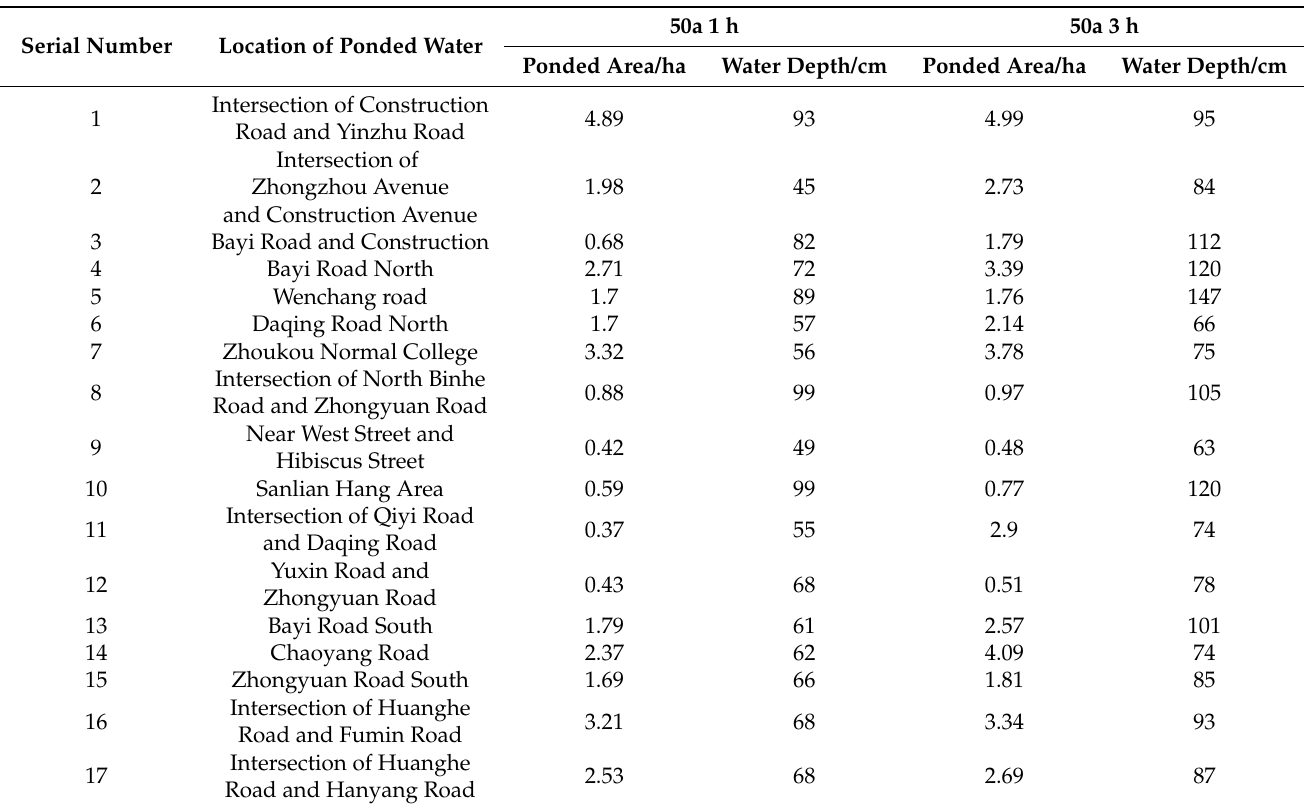
Table 4. Depth and area of water at major flood prone points during a 50-year rainfall